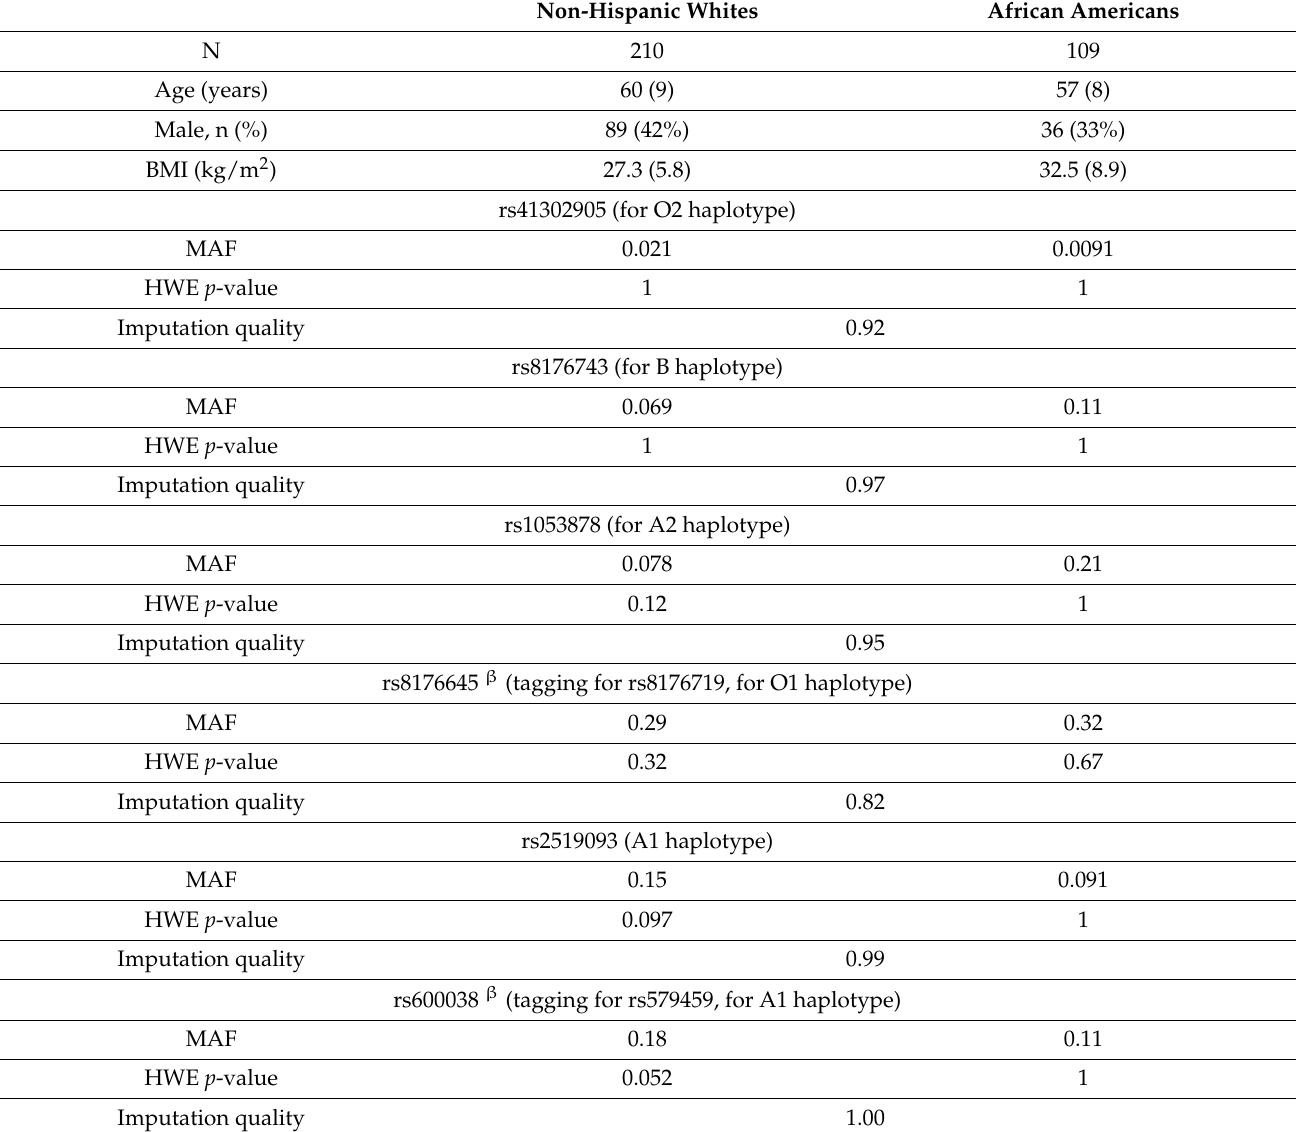
Table 1. Study population characteristics of MILES study. Non-Hispanic